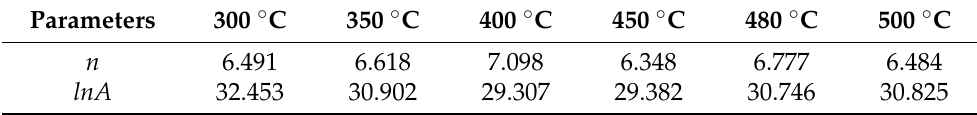
Table 4. The values of Q under different deformation rates.